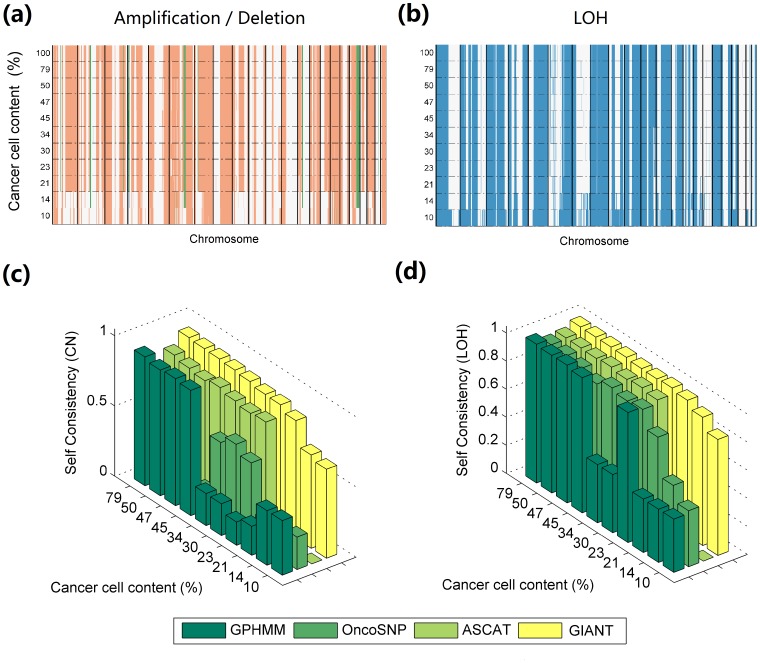
Assessment of robustness for different methods using dilution series data.Dilution series data of cancer cell line CRL-2324 and normal cell line CRL2325 are analyzed by GIANT for identifying genomic aberrations. (a) Genome-wide amplification (red)/deletion (green) profiles for dilution samples with cancer cell content ranging from 10% to 100%. (b) Genome-wide LOH (blue) profiles for dilution samples. The vertical stripes across different dilution levels reflect the strong reproducibility for aberration identification. (c) Self-consistency for copy number identification by GIANT (yellow), ASCAT (light green), OncoSNP (green) and GPHMM (dark green). (d) Self-consistency for LOH identification by GIANT ASCAT, OncoSNP and GPHMM.